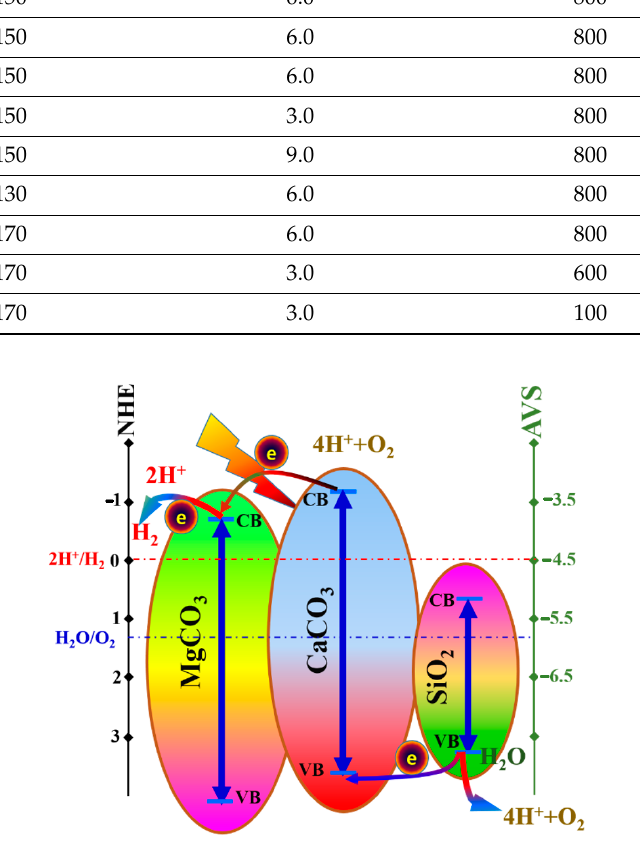
Figure 15. Schematic diagram showing the conduction and valance band locations in the prepared catalyst as well as illustrating the water splitting mechanism.